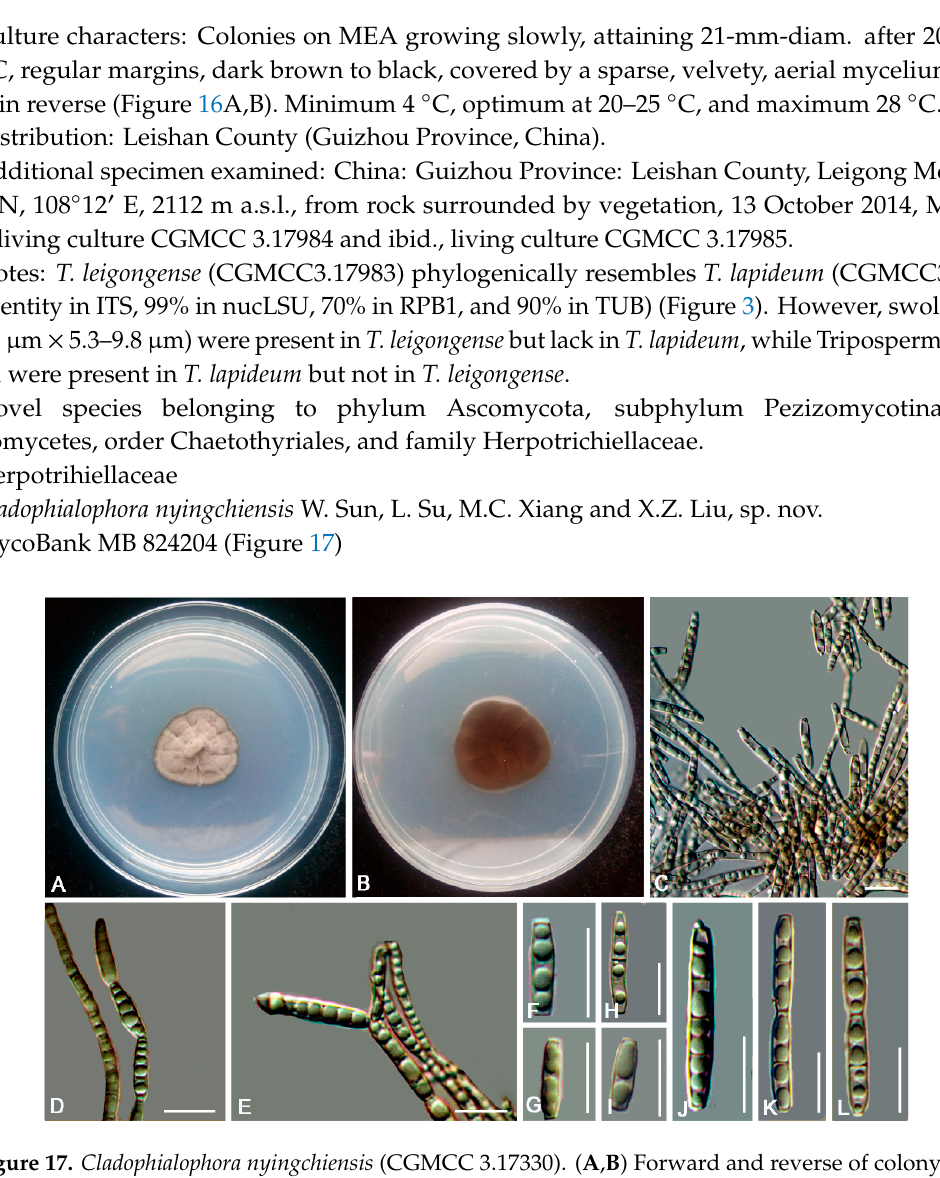
Figure 17. Cladophialophora nyingchiensis (CGMCC 3.17330). ( A , B ) Forward and reverse of colony